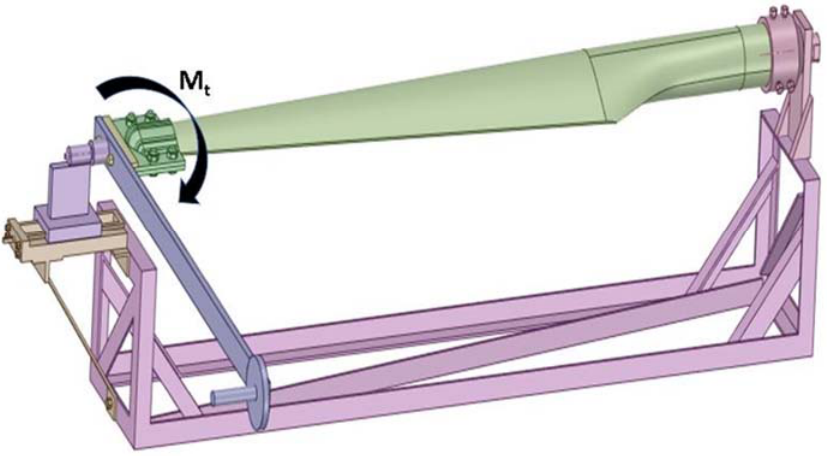
Figure 5. The 3D model of the device for blade torsion test.